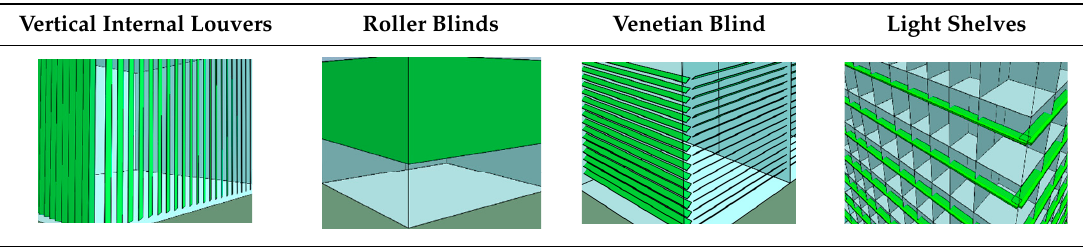
Table 3. Thermal templates assigned for the building (CIBSE guide A and B).